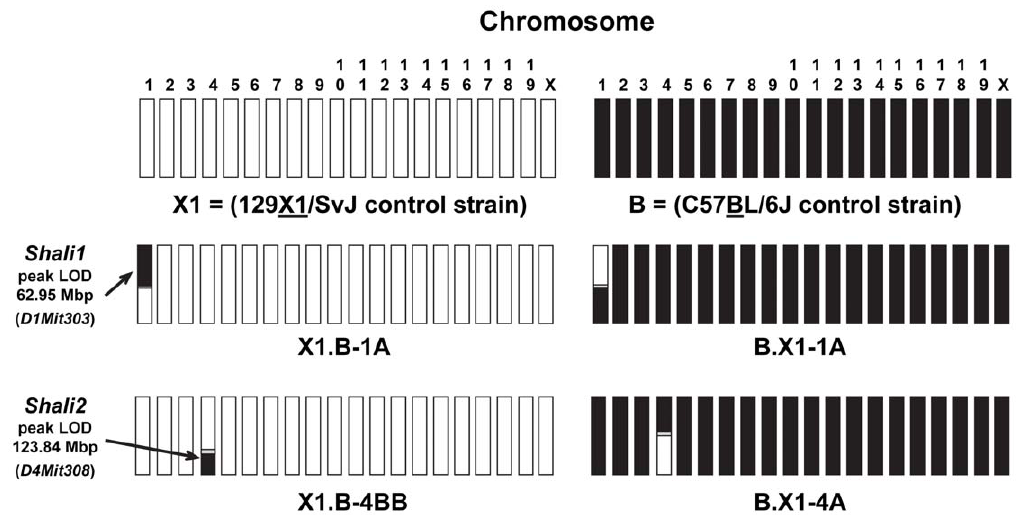
Figure 2. Genomic makeup of the Shali1 (Chr 1) and Shali2 (Chr 4) reciprocal congenic lines. A schematic overview comparing the 19 autosomes and X chromosome for the X1 (white) and B (black) control inbred strains along with the major Shali1 and Shali2 reciprocal congenic strains generated on the recipient X1 strain with B strain donor (X1.B-1A and X1.B-4BB) or recipient B strain with X1 strain donor (B.X1-1A and X1.B- 4A). Small regions of unknown parental origin, which map between known SNP markers, are colored grey. MIT markers representing the peak linkage (LOD) score for the Shali1 and Shali2 QTLs are shown at the left, with approximate map location relative to chromosome and transferred region.